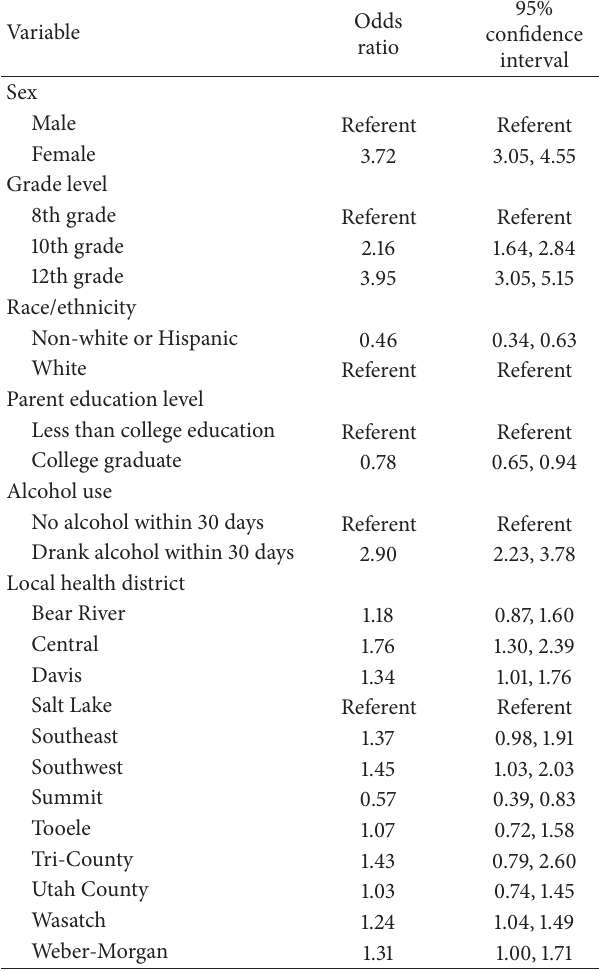
Table 2: Predictors of adolescent self-reported indoor tanning in the PNA after passage of SB